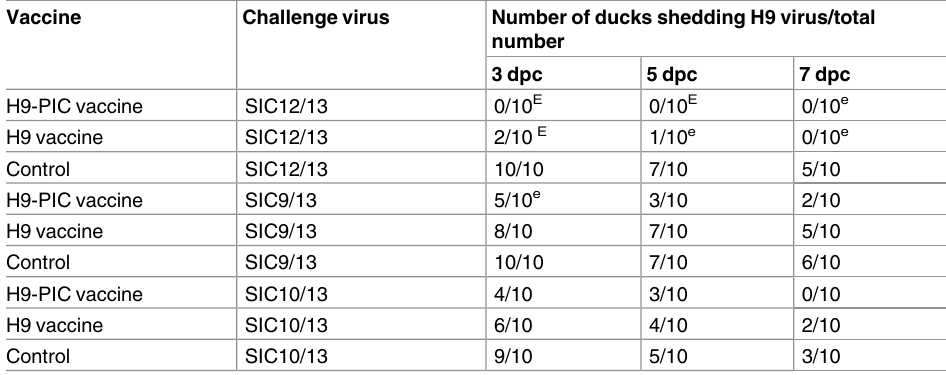
Table 2. Recovery of live virus from challenged ducks (positive/total). Vaccine